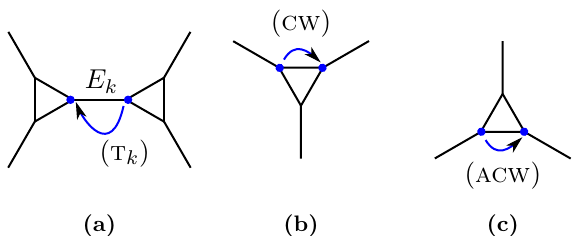
Figure 5. A path in b (cid:0) can be decomposed into three elementary types of path: traversal of a long edge E k ( t k ) ((cid:12)gure 5a), clockwise moves around a triangle ( cw ) ((cid:12)gure 5b) and anti-clockwise moves around a triangle ( acw ) ((cid:12)gure